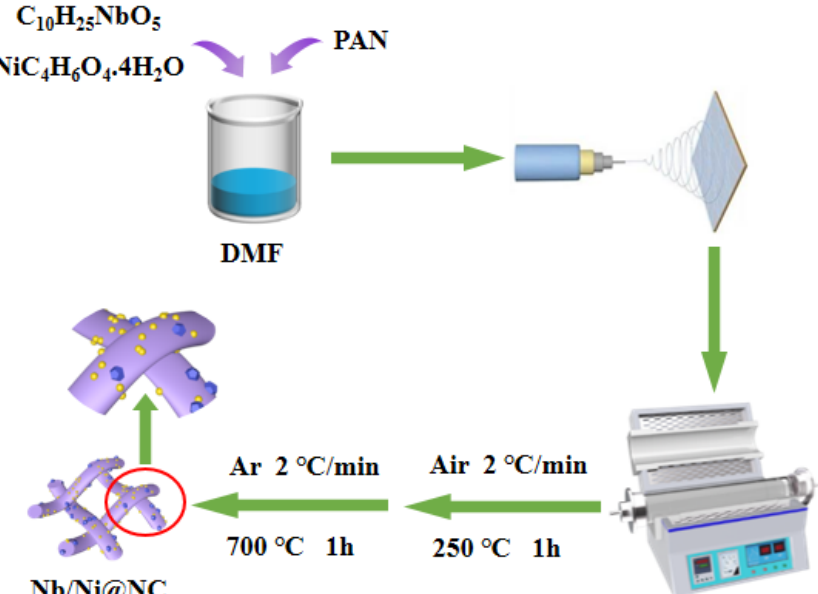
Figure 1. Schematic diagram for the preparation of flexible Nb/Ni@NC nanofiber membrane.